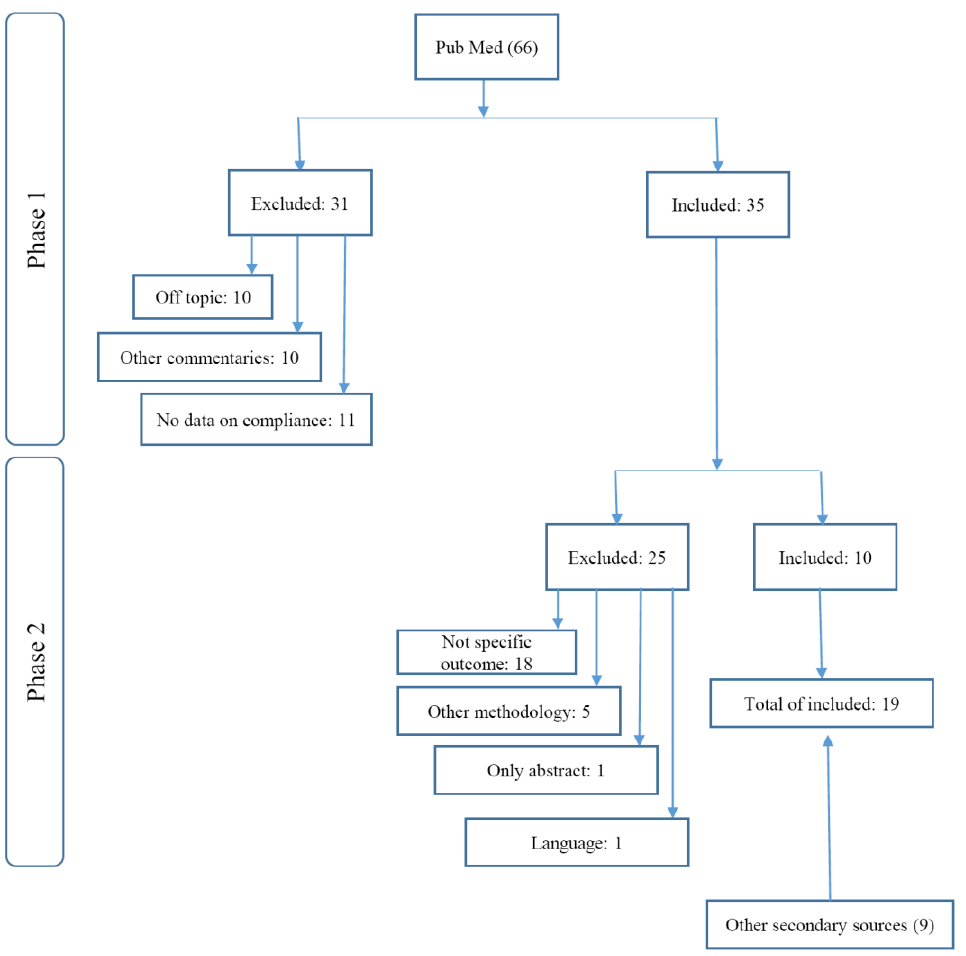
Figure 1. Flowchart of the selected studies.